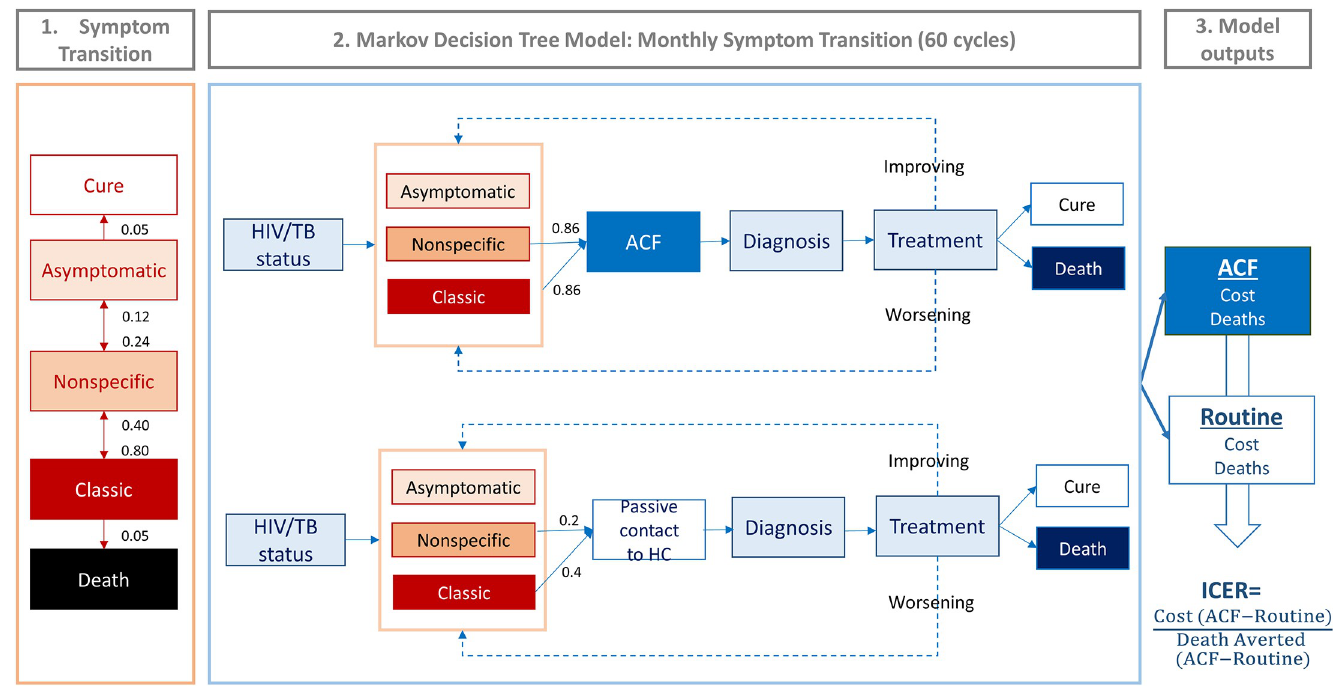
Fig 1. Conceptual framework for the Markov model. In our symptom-based care seeking model, we defined three TB-symptom levels—asymptomatic, nonspecific, classic—based on the corresponding probability of diagnostic evaluation for TB. We calculated monthly transition rates between these symptom levels based on three constraints: 1. Probability of progression is 2 times that of regression; 2. Lifetime probability of TB self-cure equals that of death in the absence of treatment (untreated case fatality ratio of 0.5); and 3. Mean duration of asymptomatic period is 9 months. These values (monthly transition rates between symptom levels and monthly probabilities of seeking care) were inputted into a decision tree Markov model which was constructed to reflect the diagnostic algorithm (CXR and Xpert) used for Active Case Finding (ACF) in the Zambia TB REACH program. 100,000 individuals defined by TB/HIV status and symptom level and modeled as having a one-time chance to attend ACF (86% for nonspecific and classic symptom). Those who did not access ACF were modeled as seeking routine care with a monthly probability based on symptom development (20% for nonspecific and 40% for classic symptom) throughout the duration of the analysis. Individuals with untreated TB at the end of each monthly cycle experienced a monthly probability of symptom level transition (progression or regression). More detailed model structure and clinical diagnostic algorithms are described in the supporting information S2 and S3 Tables in S1 File; S2 and S3 Figs in S1 File.